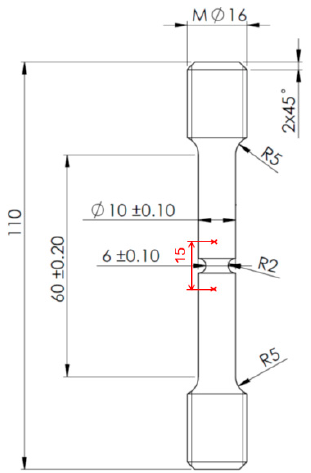
Figure 4. Drawing of notched tensile test specimen.